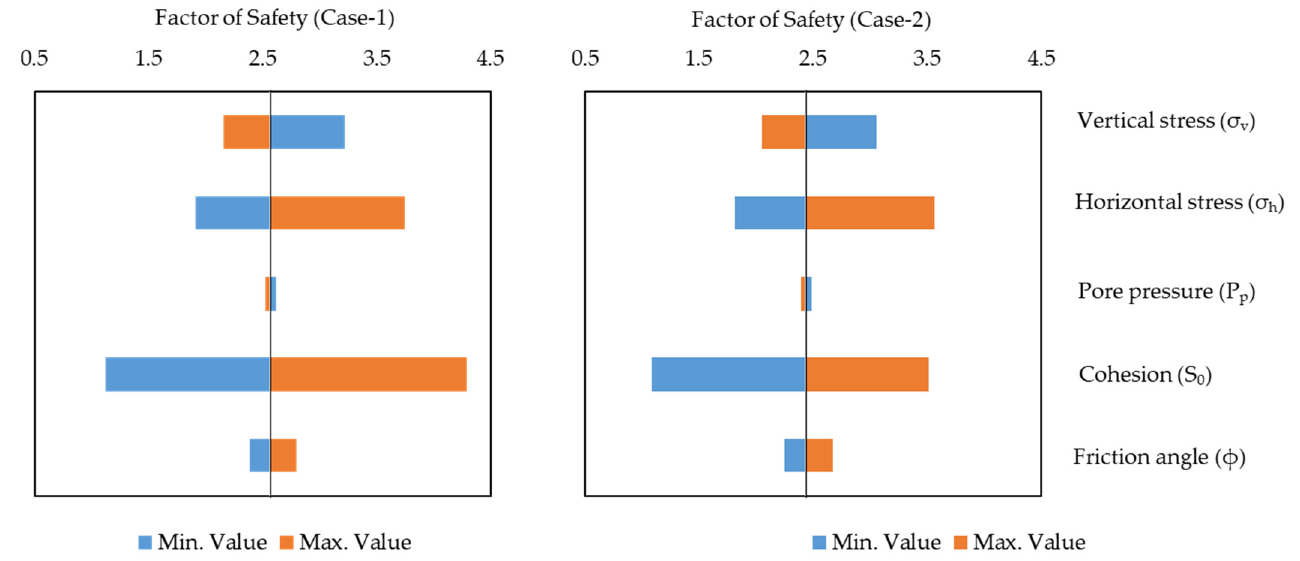
Figure 7. The tornado diagram of the deterministic sensitivity illustrates the relative importance of the input parameters for Case-1 and Case-2.